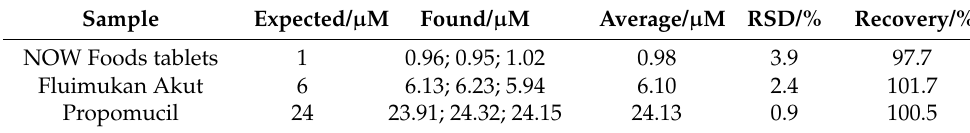
Table 3. Determination of cysteine in real samples by using standard addition